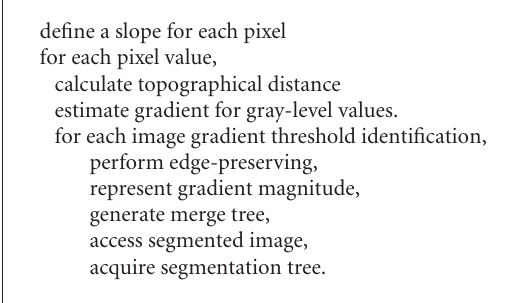
Algorithm 2: Algorithmic representation of watershed procedure.